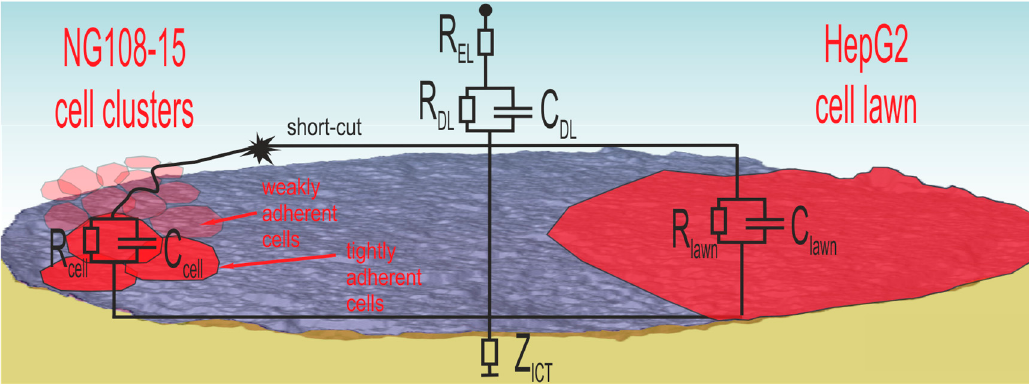
Figure 10. Signal path associated to different cell adhesion scenarios of NG108-15 cells clusters and strong adherent HepG2 cell lawn.